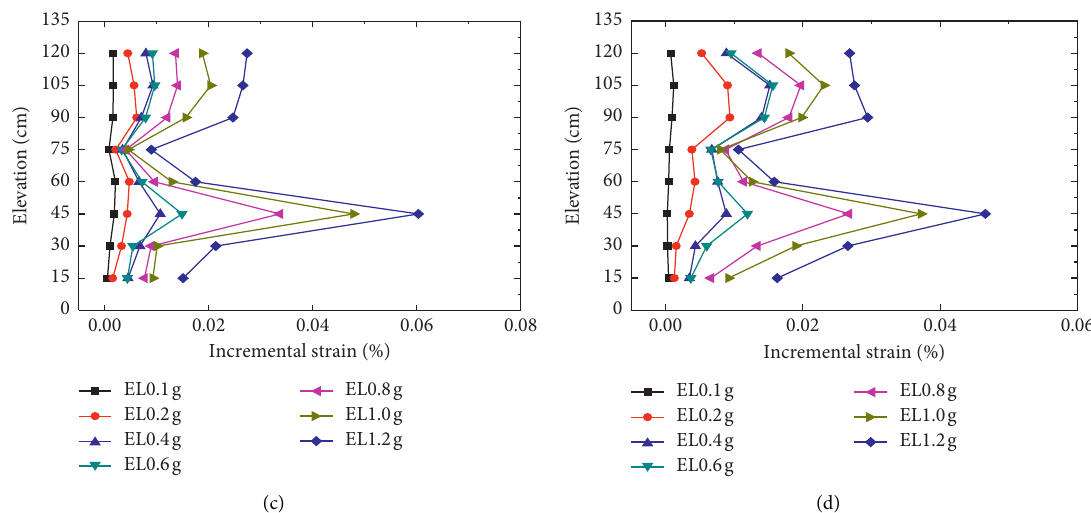
Figure 16: Distribution of strain in T 4 and T 5 for specimen 2. (a) T 4 under WL. (b) T 5 under WL. (c) T 4 under EL. (d) T 5 under EL.